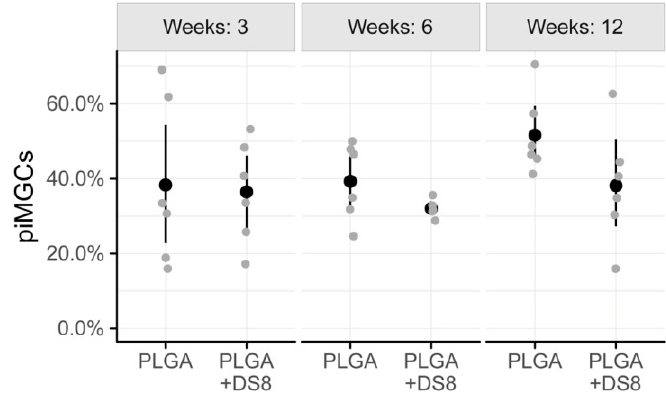
Figure 7. Scatter plot of peri-implant multi-nucleated giant cells (piMGCs), i.e., the percentage of the implant surface that is surrounded by MGCs. (Black dots refer to mean values of the respective groups.)